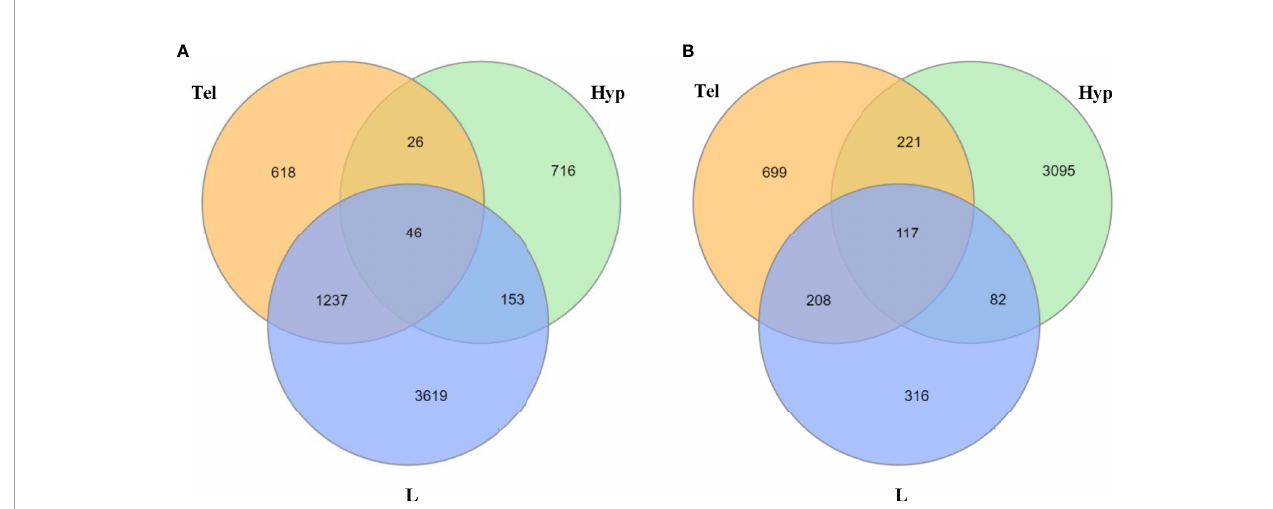
FIGURE 4 | Number of common dysregulated genes in larvae and adult zebra fi sh upon developmental exposure to fl uoxetine in stressed and unstressed conditions. (A) Venn diagram illustrating the common differentially expressed genes between larval heads and adult telencephalon and hypothalamus in the unstressed condition. (B) Venn diagram illustrating the common differentially expressed genes between larval heads and adult telencephalon and hypothalamus in the stressed condition. All of the signi fi cantly dysregulated genes (up or downregulated) were included in this comparison (FC ≥ 1.2; p ≤ 0.05). L, larvae; Hyp, hypothalamus; Tel,